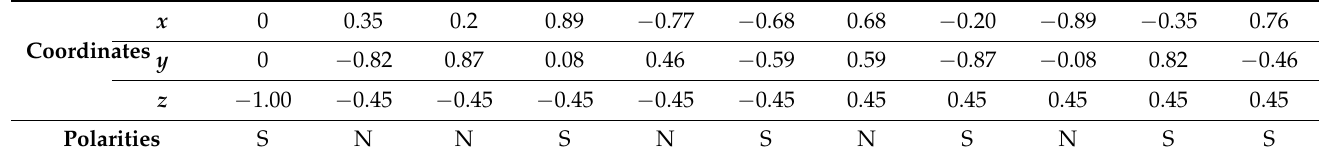
( b ) Figure 8. Specifying rotor PM polarities: ( a ) rotor sectors S1 to S5; ( b ) optimal distribution of magnet polarities for 11 magnet locations after removing locations in a solid angle of 0.3789 sr about the z- axis.